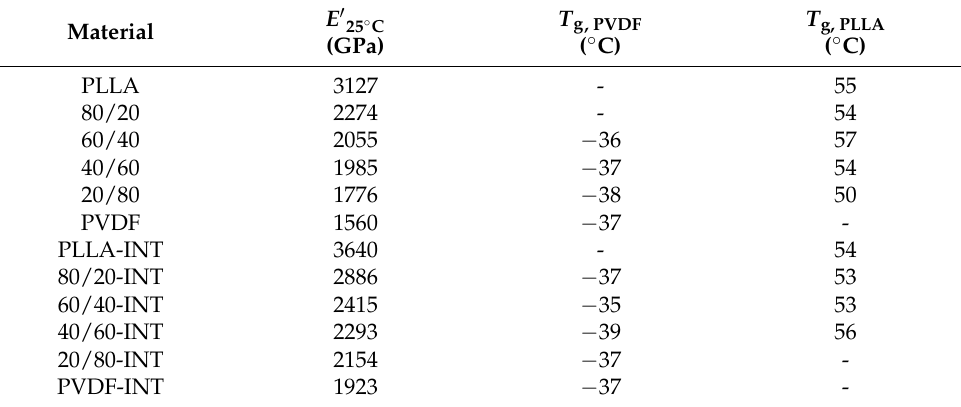
Figure 10. WAXS diffractograms of PLLA, PVDF, binary PLLA/PVDF, and ternary PLLA/PVDF/INT-WS 2 hybrid nanocomposites obtained at room temperature after dynamic crystallization from the melt. Table 3. DMA parameters of different PLLA/PVDF/INT-WS 2 blend nanocomposites based on PLLA, PVDF, and INT-WS 2